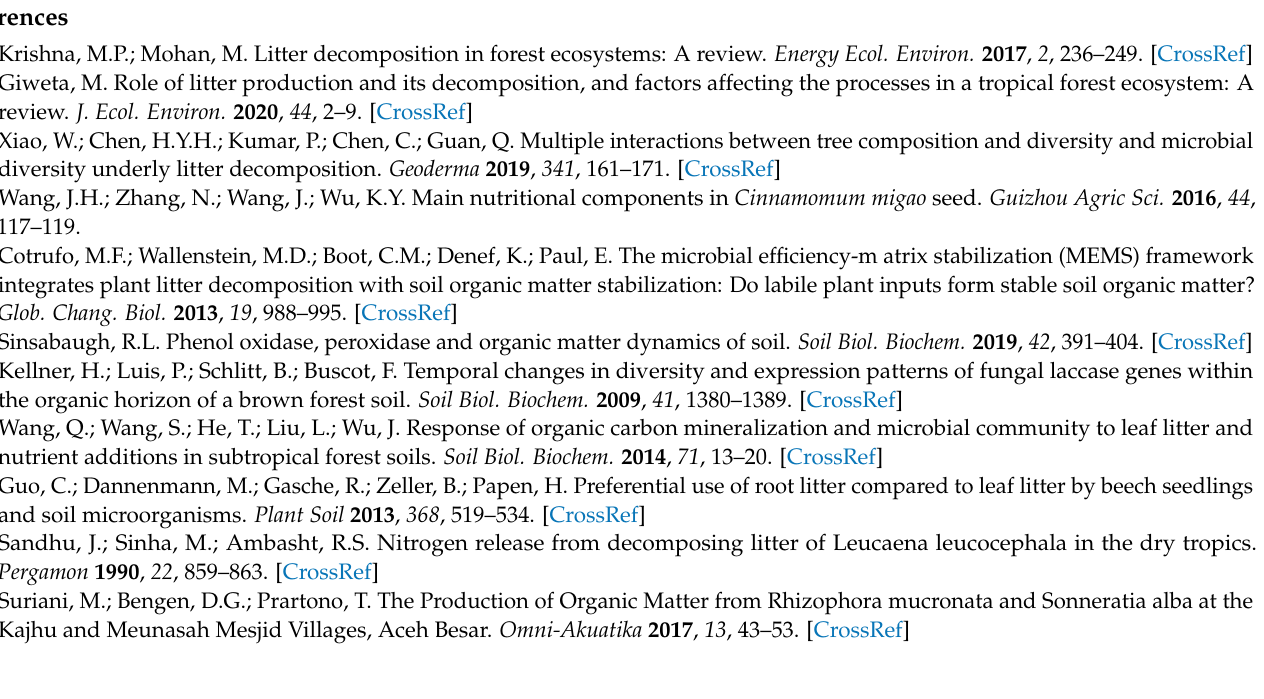
Figure S1. In the score chart of microbial differential species in different treatments. (a) fungus, (b) bacteria: The different colors represent different groups, the red bar represents the species with relatively high abundance in the red group, and the green bar represents the species with relatively high abundance in the green group; Figure S2. Zi–Pi plot showing the distribution of OTUs based on their topological roles in networks fungi. Each symbol represented an OTU in the bacterial (filled circle) or fungal (empty circle) network; Figure S3. Zi–Pi plot showing the distribution of OTUs based on their topological roles in networks bacteria: Each symbol represented an OTU in the bacterial (filled circle) or fungal (empty circle)